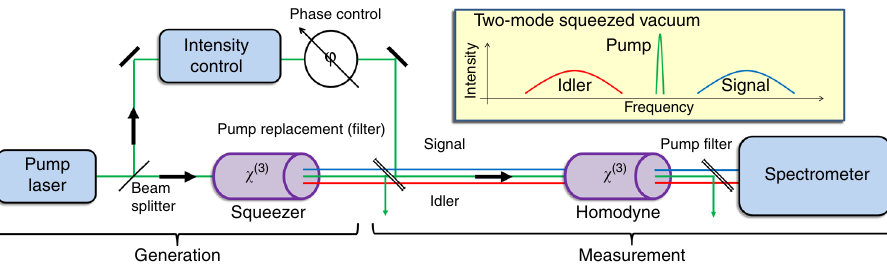
Fig. 2 Experimental schematic of the parametric homodyne. The experiment consists of two parts: (1) generation of broadband squeezed light and (2) homodyne measurement of the generated squeezing. Broadband two-mode squeezed light is generated via spontaneous four-wave mixing (FWM) in a photonic crystal fi ber (PCF) pumped by 12 ps laser pulses (786 nm). After generation, the pump is replaced by an appropriately delayed copy of the original pump light, via a narrowband fi lter, which allows independent intensity and phase control, to tune the parametric gain and to select the speci fi c quadrature to be measured. Then, the new pump and the FWM light enter the second PCF for the homodyne measurement. After this second (measurement) pass through the ampli fi er, the pump is separated from the FWM light by a narrowband fi lter and the FWM light is measured by a